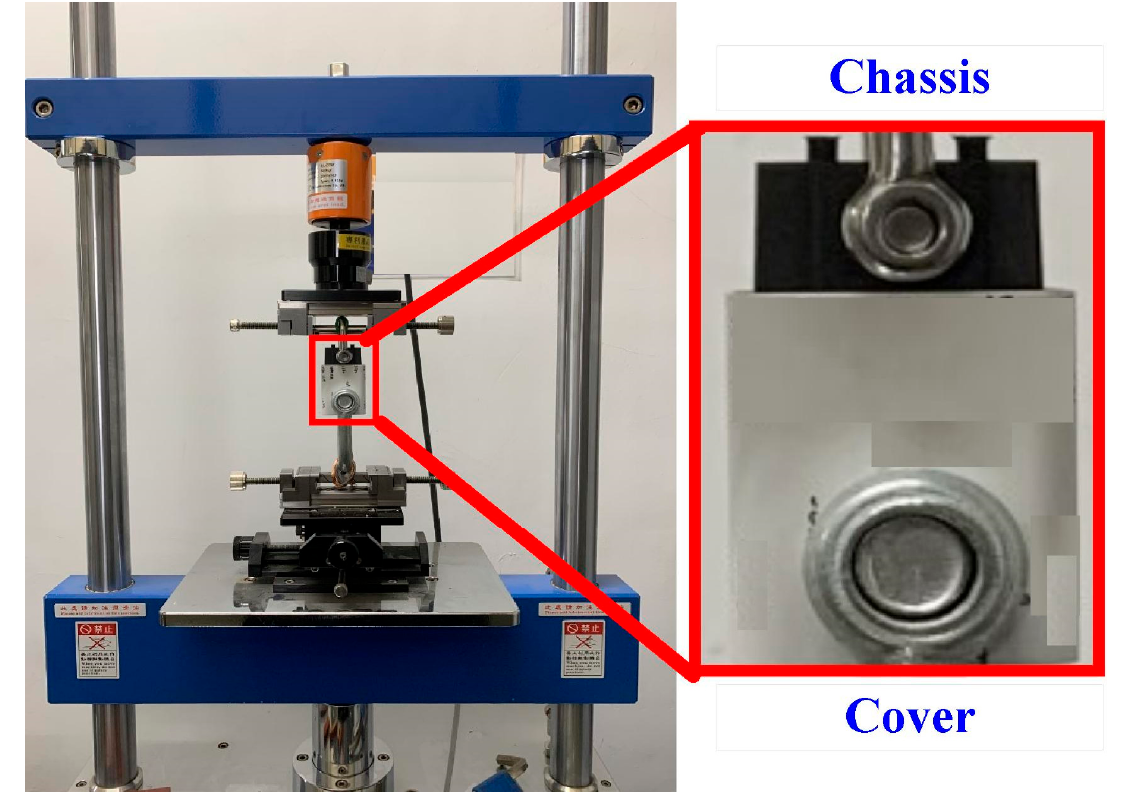
Figure 4. Photographic illustration of tensile testing conditions.